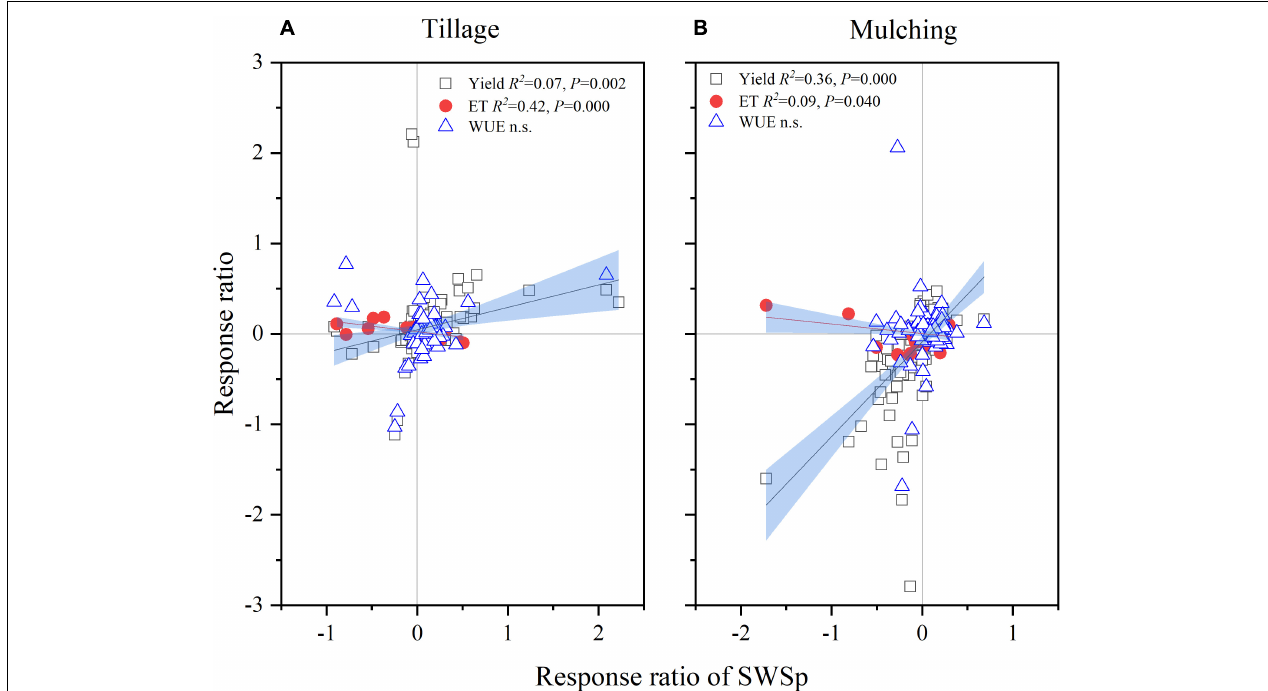
FIGURE 6 | Correlations of the response ratio of winter wheat grain yield, evapotranspiration (ET), and water use efficiency (WUE) to that of soil water storage at wheat planting (SWSp) (A,B)